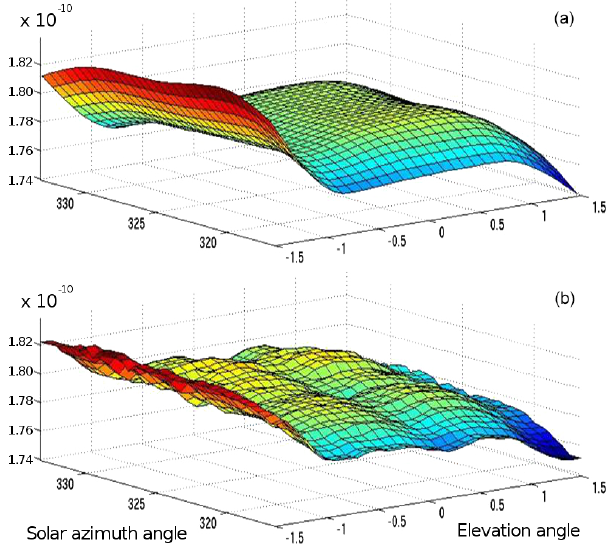
Figure 12. Müller matrix elements (MMEs) at 330nm for the ra- diometric calibration of the irradiance signals including the depen- dence on elevation and solar azimuth angles. The irradiance re- sponse MMEs consist of the diffuser BSDF and the radiometric response per channel. The top panel (a) shows the MME as de- rived from the on-ground characterization and the lower panel (b) the same but derived from in-flight